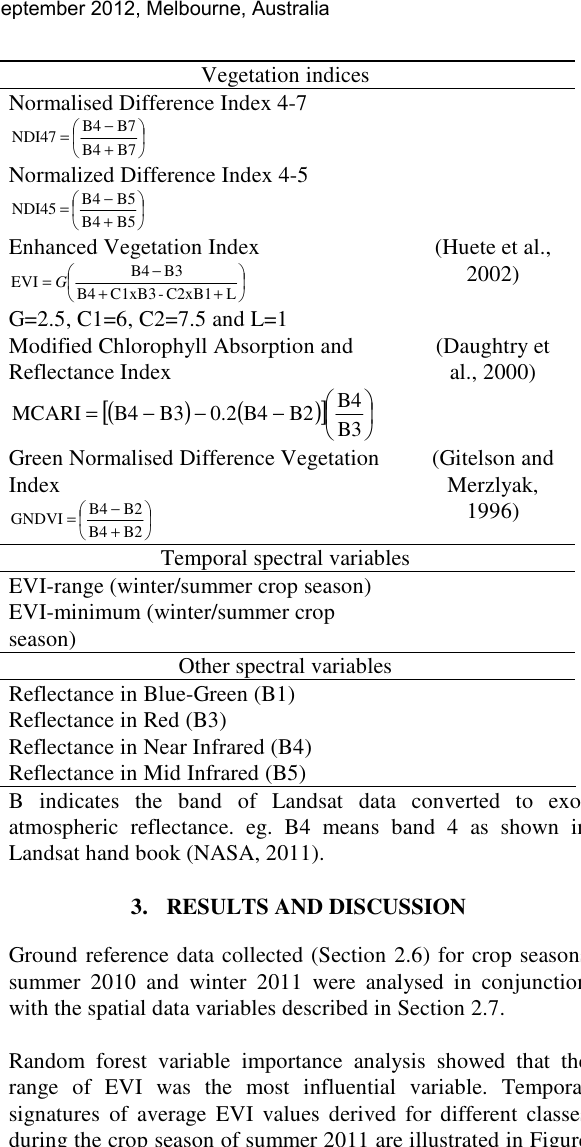
Table 1. Spectral and textural input variables selected for SVM